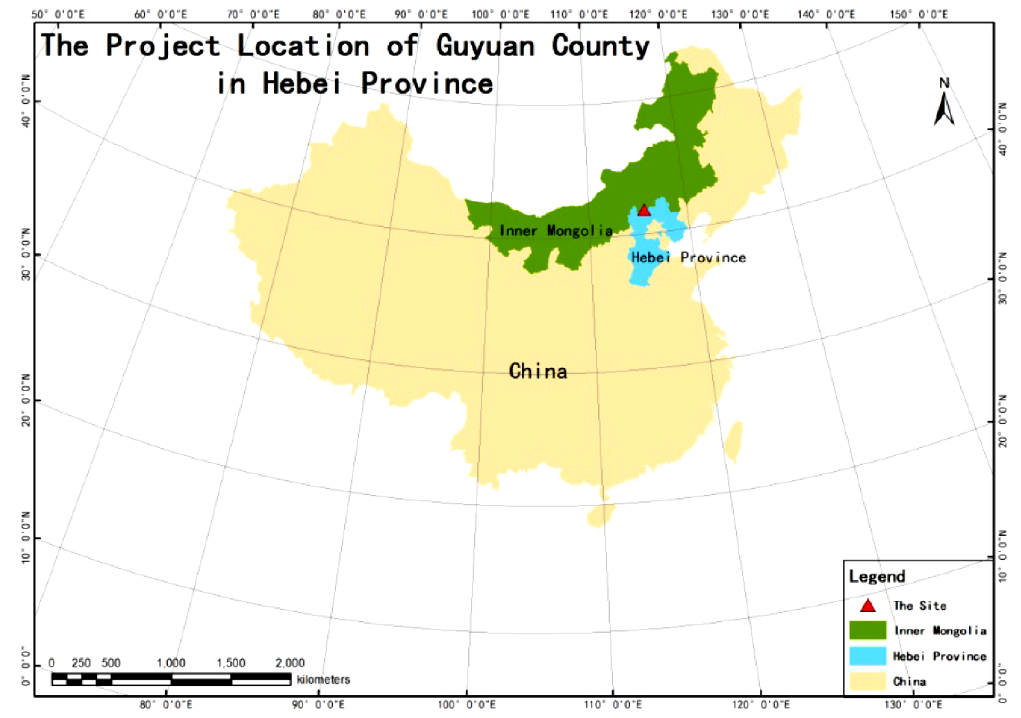
Figure 1. Project location in Guyuan County, Hebei Province in northern